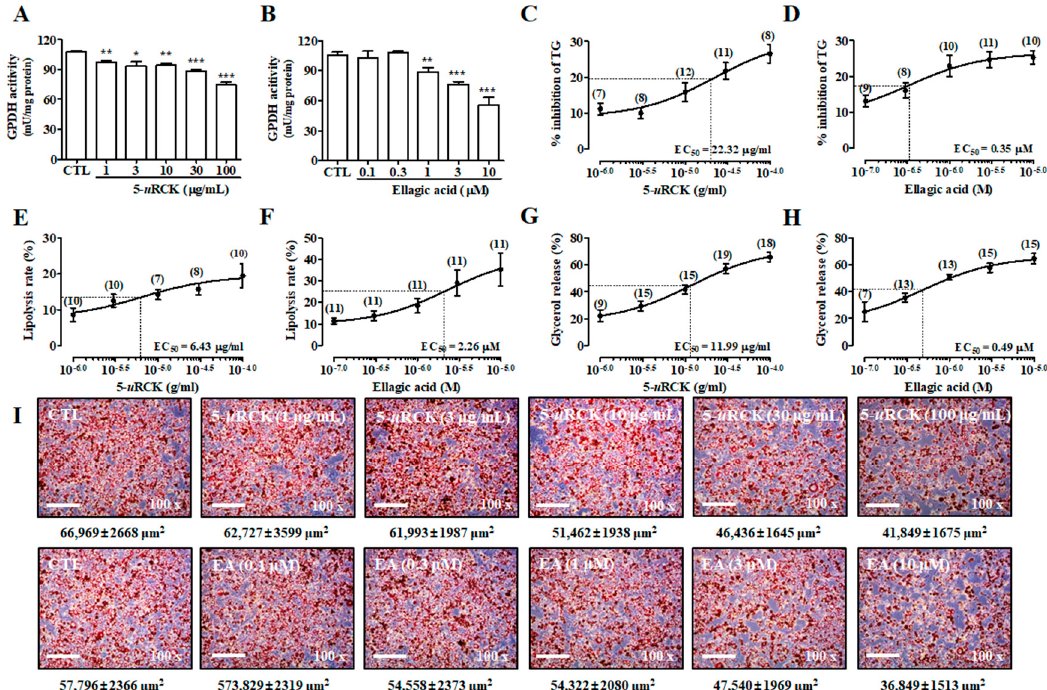
Figure 2. E ff ects of 5% ethanol extract of unripe Rubus coreanus (5- u RCK) and ellagic acid in mature 3T3-L1 adipocytes. Di ff erentiated 3T3-L1 adipocytes were incubated with 5- u RCK (1–100 µ g / mL) or ellagic acid (0.1–10 µ M) for 3 days. Inhibitory e ff ects of 5- u RCK ( A ) and ellagic acid ( B ) against glycerol 3-phosphate dehydrogenase (GPDH)-specific activity. E ff ects of 5- u RCK ( C ) and ellagic acid ( D ) on triglyceride (TG) accumulation in mature 3T3-L1 adipocytes. Quantification of the lipolysis rate in mature adipocytes with 5-uRCK ( E ) and ellagic acid ( F ). Mature 3T3-L1 cells were incubated with various concentrations of 5- u RCK ( G ) or ellagic acid ( H ) for 24 h. Values are expressed as the mean amount ( ± SE) of glycerol released per well as a percentage of the control value. Numbers above each point indicate the n-number at each concentration. ( I ) Matured 3T3-L1 adipocytes were stained with Oil Red O. The size of Oil Red O-stained lipid droplets ( µ m 2 ) was calculated using ImageJ software version 1.48 s (National Institutes of Health, Bethesda, MD, USA). The results are presented as the mean ± SE of at least three independent experiments, each performed in triplicate (n = 3). * p < 0.05, ** p < 0.01 and *** p < 0.001 versus